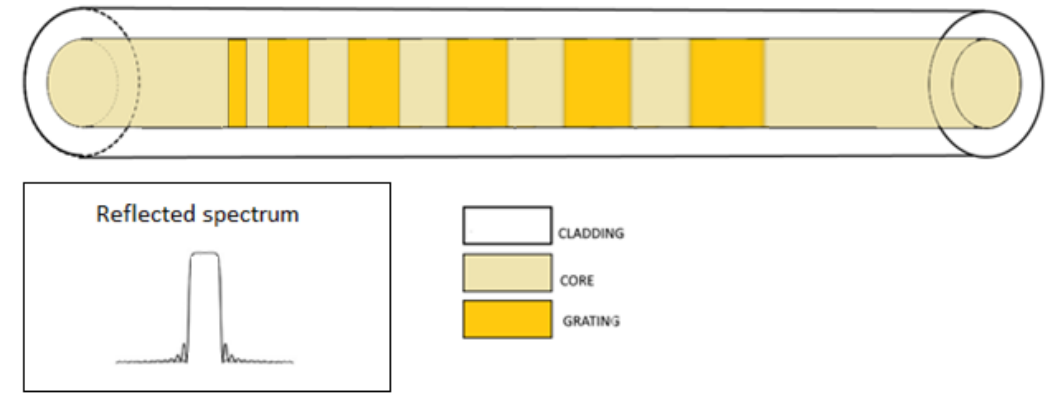
Figure 7. Chirped FBG. Inset: reflected spectrum.